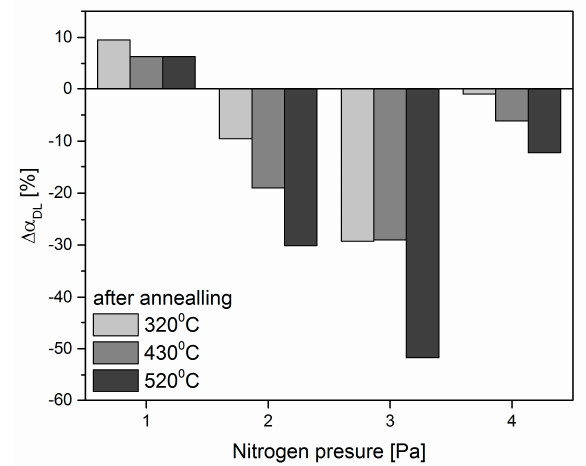
Figure 17. Result of thermal stability testing of AlCrN coatings formed at different nitrogen pressure in the technological chamber. Determined by means of relative changes in α DL coefficient at 200 °C.